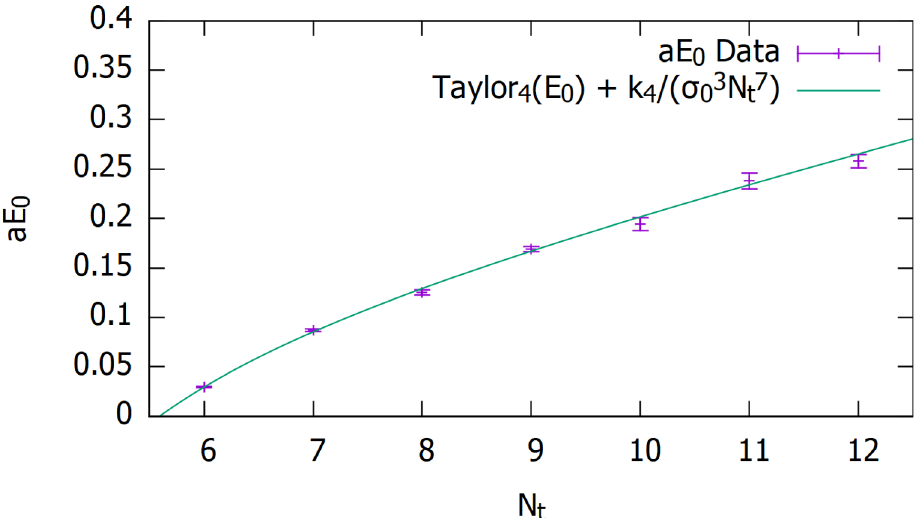
Figure 6 . Same as in figure 4, but for β = 13 . 42445 .